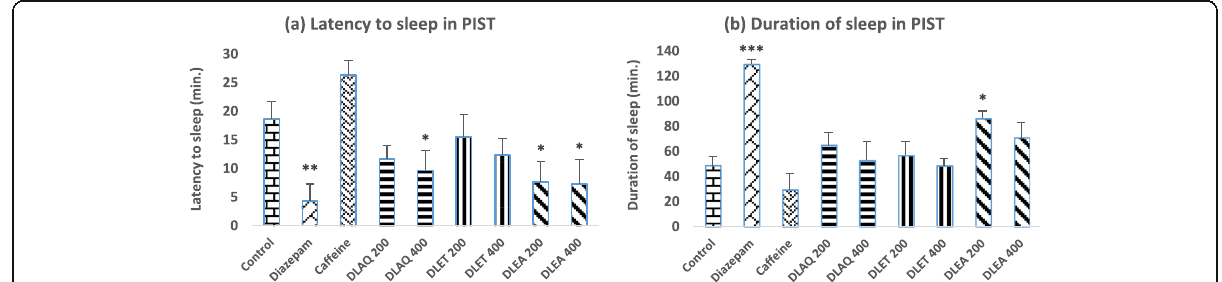
Fig. 1 a - b : Observation parameters of Pentobarbitone Induced Sleeping Time Test (PIST). Figure represented the latency to sleep ( a ) and duration of sleep ( b ) in minutes exhibited by the respective groups of mice. DLAQ = Aqueous extract of D. linearis , DLET = Ethanol extract of D. linearis , DLEA = Ethyl Acetate extract of of D. linearis . Data represented as mean + SEM and analyzed by one-way ANOVA followed by Dunnett t test where *, **, *** denoted p < 0.05, p < 0.01 and p < 0.001 respectively and statistically significant. All groups ( n = 6) were compared to